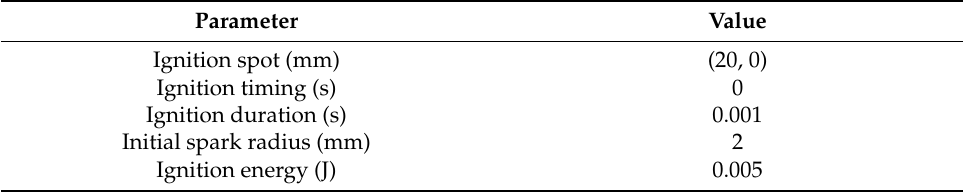
Table 2. Parameters for the ignition model.